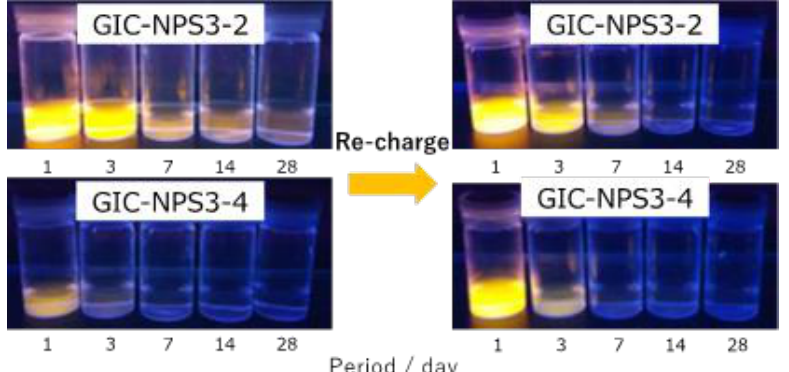
Figure 4. Color change of GIC-NPS3-2 and GIC-NPS3-4 supernatant under ultraviolet light during initial charge and